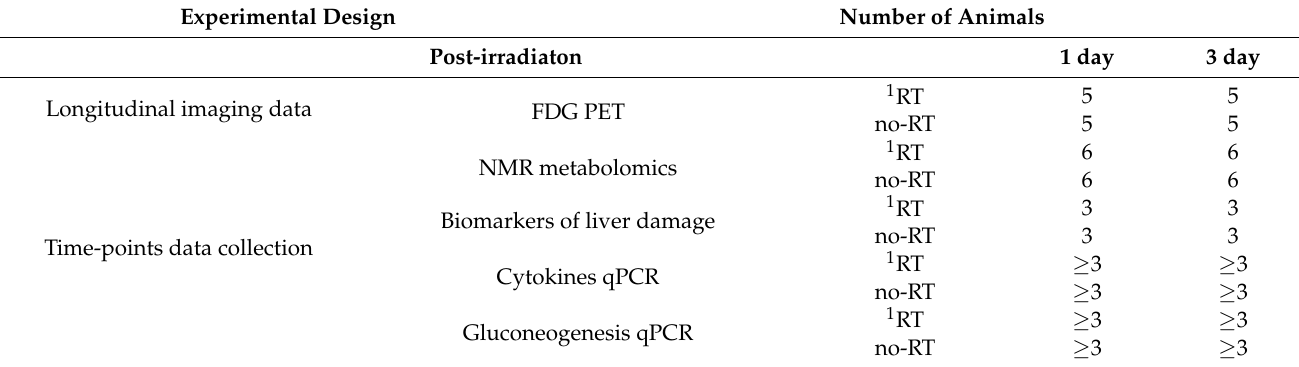
Table 2. Number of animals used for each procedure at different time points during the experimental workflow. Experimental Design Number of Animals Post-irradiaton 1 day Longitudinal imaging data FDG PET